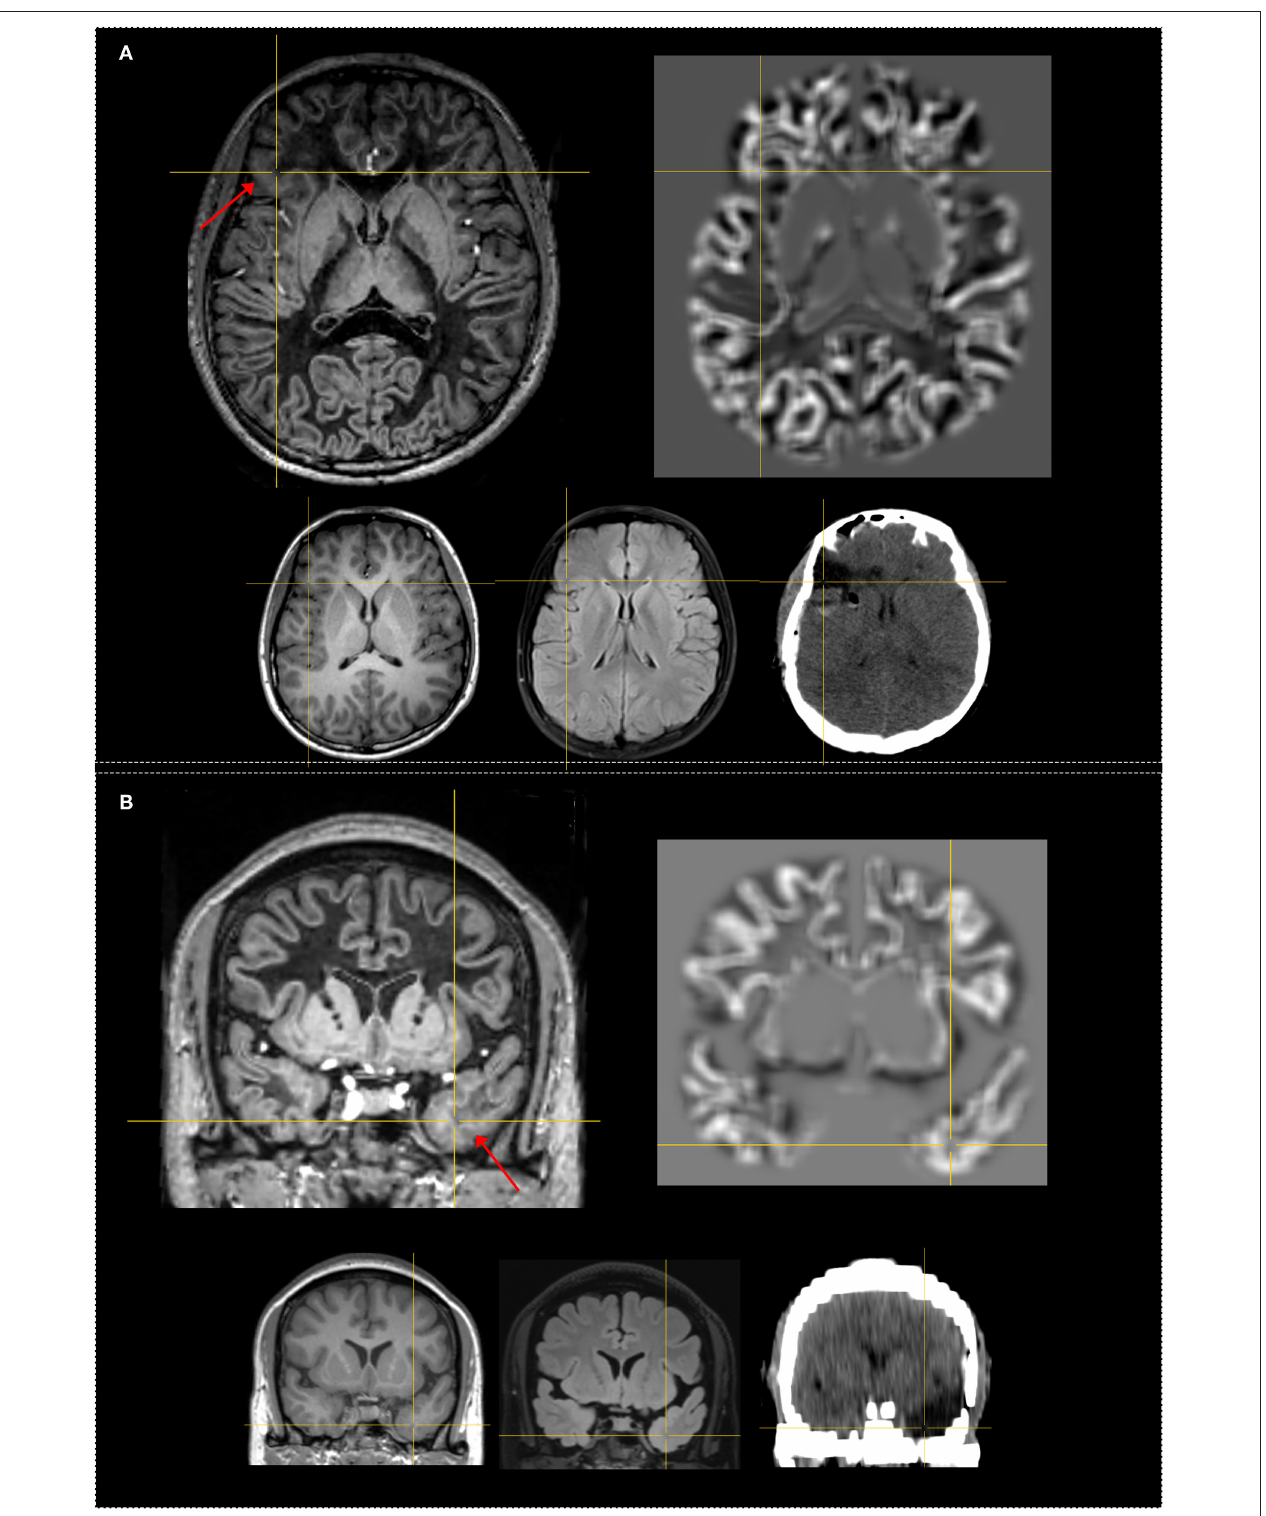
FIGURE 3 | Examples of patients with only FLAWS + region concordant with the surgical resection cavity. Both patients were seizure-free after surgery at 12 months. The crosshairs indicate the same coordinate between different images. The red arrows indicate the FLAWS + region. Upper, left: registered FLAWS image;